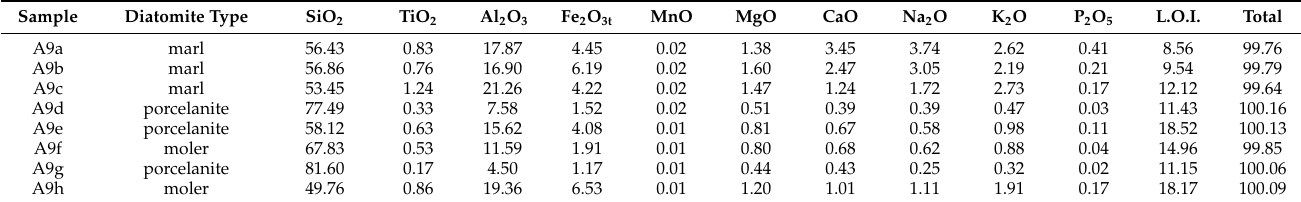
Table 2. Chemical analysis of the studied samples as determined by